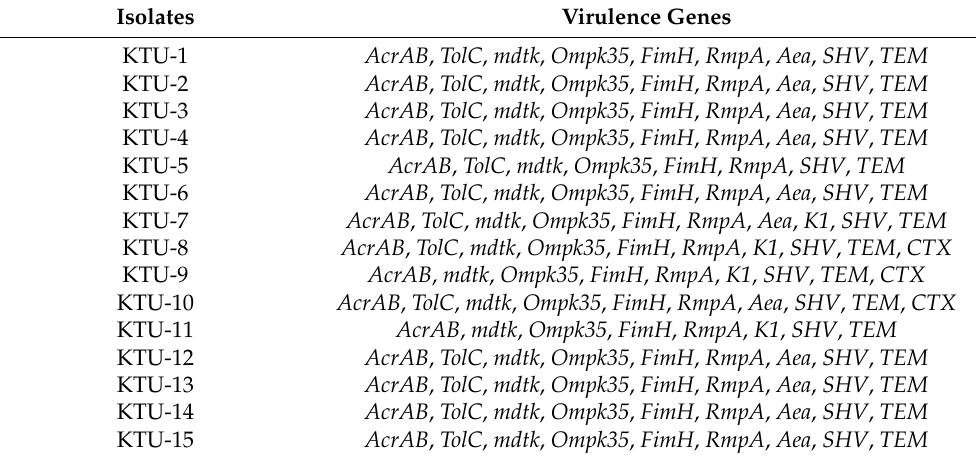
Table 4. Virulence genes ( AcrAB , TolC , mdtk , Ompk35 , FimH , RmpA , Aea , SHVM , TEM , K1 , and K2 ) in Klebsiella pneumoniae isolates.